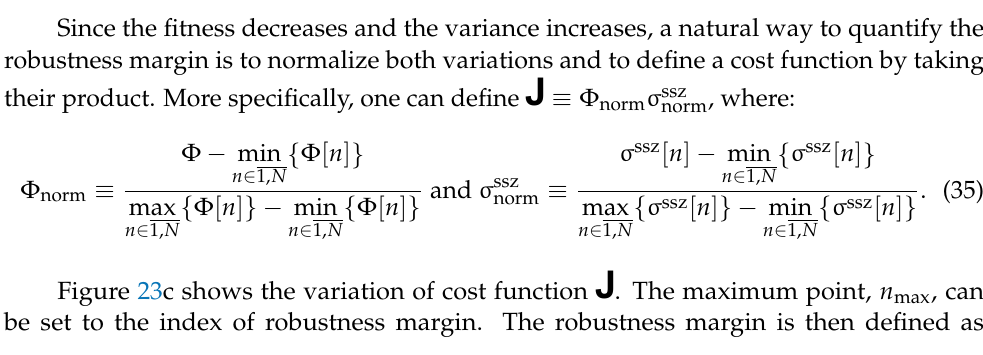
Figure 21. PID-ASTANK2 performance for switched references of the previous Figure 23. Principle of robustness margin estimation for increasing noises variance.